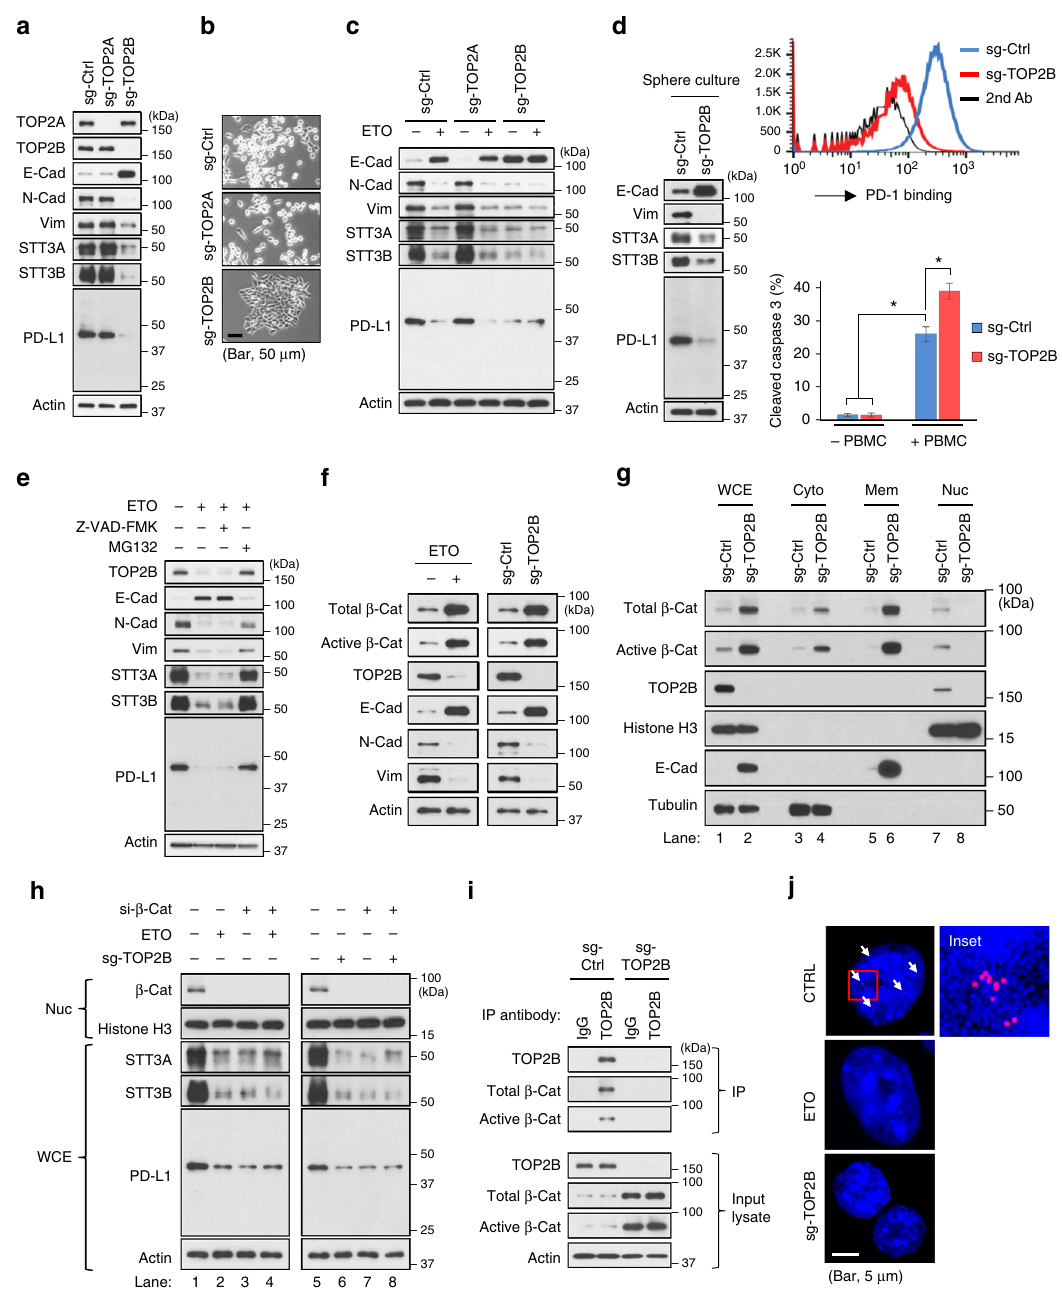
Fig. 8 Etoposide inhibits the EMT/ β -catenin/STT3/PD-L1 axis through TOP2B degradation-dependent nuclear β -catenin downregulation. a Effect of TOP2 isoforms knockdown on the expression of EMT markers, STT3 and PD-L1 in 4T1 cell. b Representative phase-contrast microscopy images of 4T1 cell treated with indicated sg-RNAs. Scale bar, 50 μ m. c In fl uence of TOP2 isoforms knockdown on etoposide-induced MET and downregulation of STT3 and PD-L1. d Western blot analysis (left), PD-1 binding assay (upper right), and in vitro PBMC-mediated cancer cell killing assay (bottom right) of tumorspheres cultured from various sgRNA-treated 4T1 cells. e Effect of proteasome inhibitor (MG132) and caspase inhibitor (Z-VAD-FMK) on etoposide- induced TOP2B degradation, MET, and downregulation of STT3 and PD-L1. f Western blotting of whole-cell extracts analyzing the effect of etoposide and TOP2B knockdown on total and active (non-phospho) β -catenin ( β -Cat). g Western blotting of whole-cell extracts (WCE), cytosolic (Cyto), membrane (Mem), or nuclear (Nuc) fractions from sgRNA-treated 4T1 cells analyzing the effect of TOP2B knockdown on β -catenin subcellular localizations. Histone H3, E-cadherin (E-Cad), and tubulin were used as makers of nuclear, membrane, and cytosolic fractions, respectively. h Ef fi cacy of β -catenin knockdown (si- β -Cat) in desensitizing cells to etoposide- and sg-TOP2B- induced MET and downregulation of STT3 and PD-L1. Nuc nuclear fraction, WCE whole-cell extracts. i Co-immunoprecipitation assay showing interaction between TOP2B and β -catenin. j Duolink assay analyzing the interaction of TOP2B and active (non-phospho) β -catenin in the nucleus. Red dots (indicated by arrows) represented TOP2B- β -catenin interaction signals and nuclei were counterstained with DAPI (blue). The right column shows higher-magni fi cation image of the area outlined in the left column. Scale bar, 5 μ m. Error bars represent s.d. ( n = 3). * P < 0.05, Student ’ s t -test. See also Supplementary Fig.